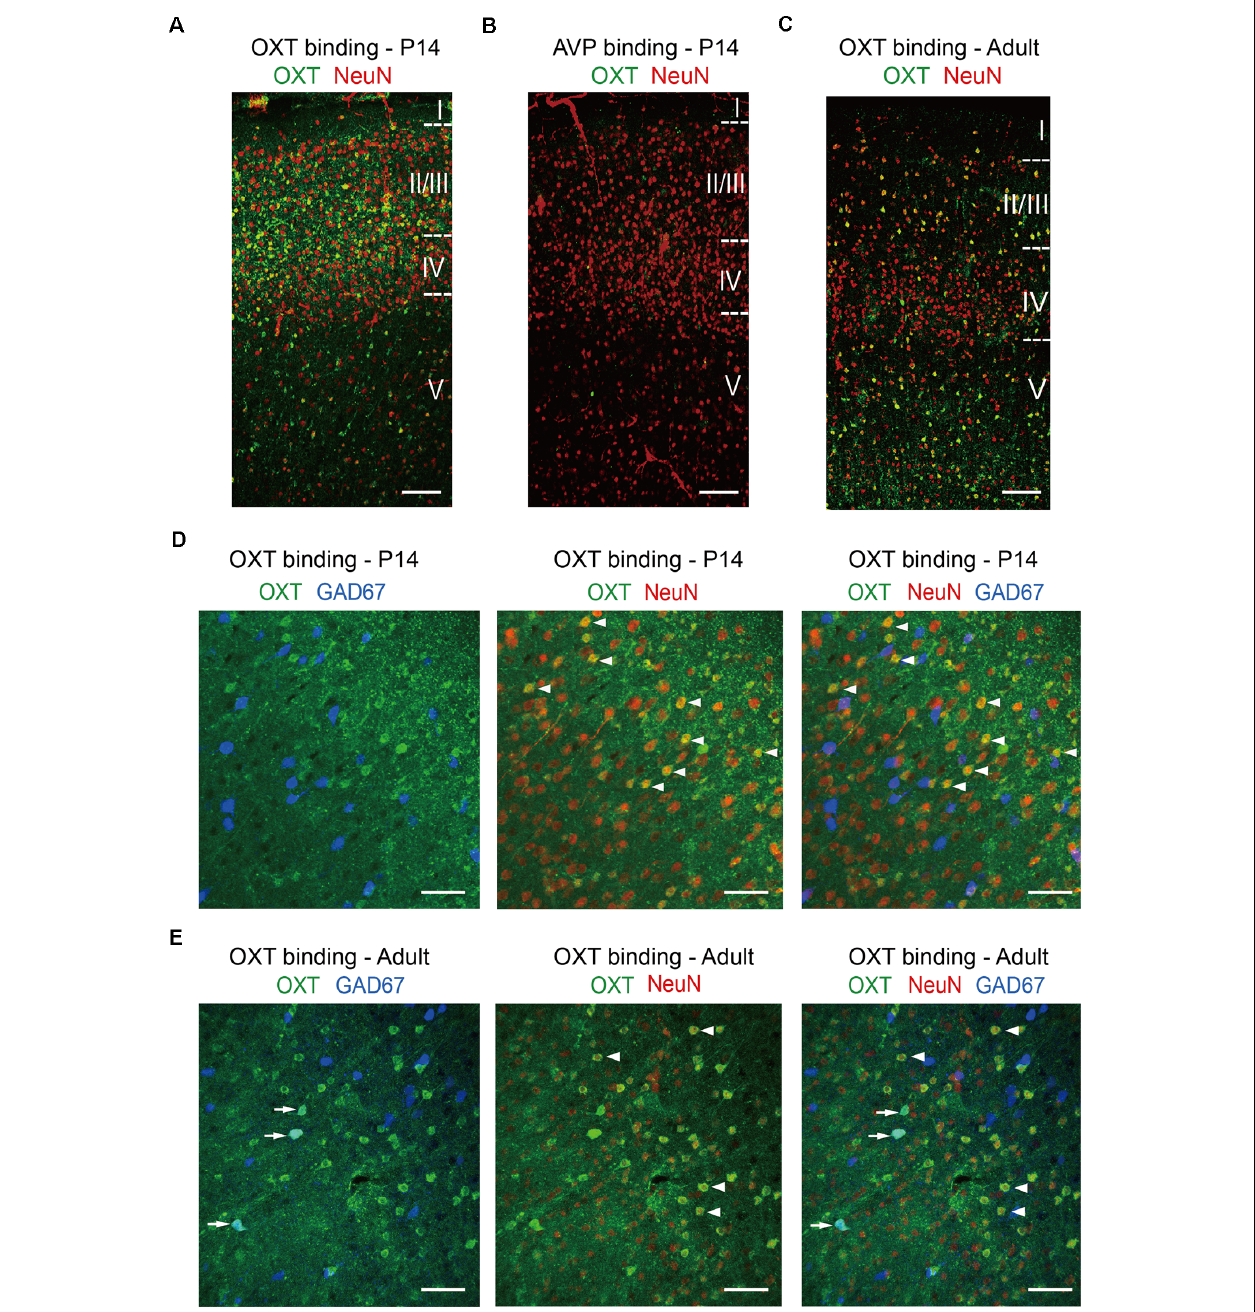
FIGURE 4 | Oxytocin binding in glutamatergic and GABAergic neurons. (A) Incubation of P14 acute brain slice with oxytocin leads to significant oxytocin binding and oxytocin antibody labeling (green) in neurons, co-labeled with NeuN (red). (B) As a negative control, incubation of P14 acute brain slice with vasopressin does not result in oxytocin antibody labeling. (C) Application of oxytocin to an adult brain slice leads to oxytocin antibody labeling (green) with a different pattern, as compared to P14. (D) Colocalization of oxytocin (green), NeuN (red), and GAD67 (blue) in the P14 cerebral cortex. (E) Colocalization of oxytocin (green), NeuN (red), and GAD67 (blue) in the adult cerebral cortex. Arrows indicate colocalization of oxytocin and GAD67; arrowheads indicated the colocalization of oxytocin and NeuN. (A–C) Cortical layers are delineated by dashed lines. Scale bar: 100 µ m. (D,E) Scale bar: 50 µ m.